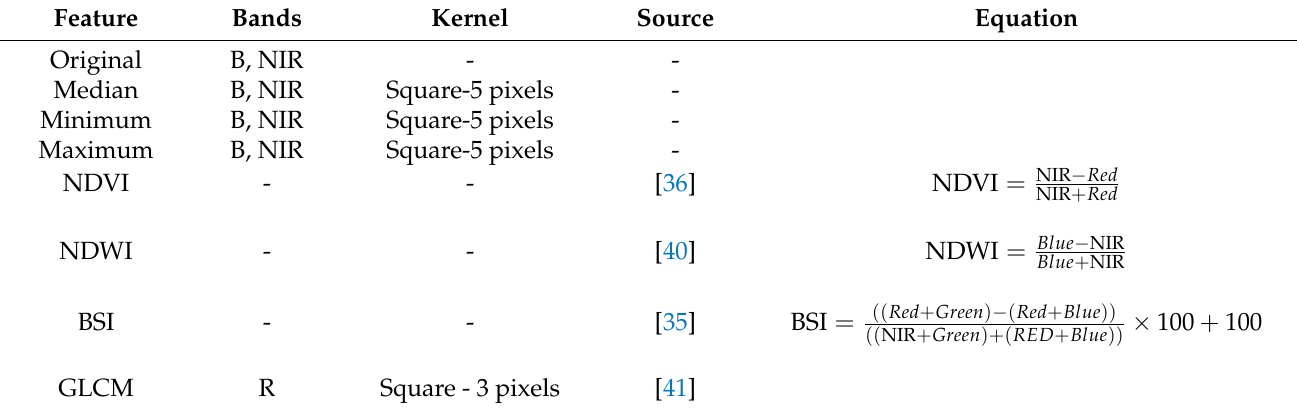
Table 3. Classification